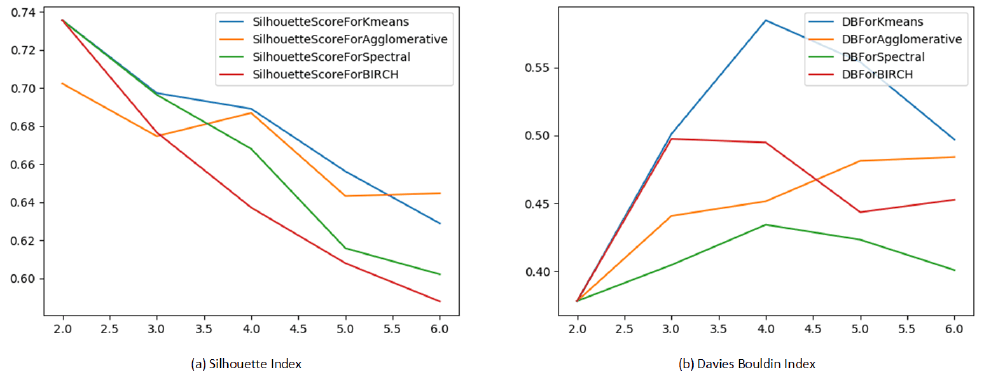
Figure 10. Clustering Quality Evaluation using two quality evaluation measures ( a , b ). Clusters produced by modified kmeans variant, Agglomerative, Spectral and BIRCH clustering with varying number of clusters.